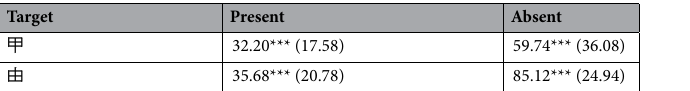
Table 2. Mean search slopes (in ms/Item) and intercepts (in ms) with standard errors (in brackets), for target- present and target-absent trials in Experiment 1. Asterisks indicate that the respective slope differs significantly